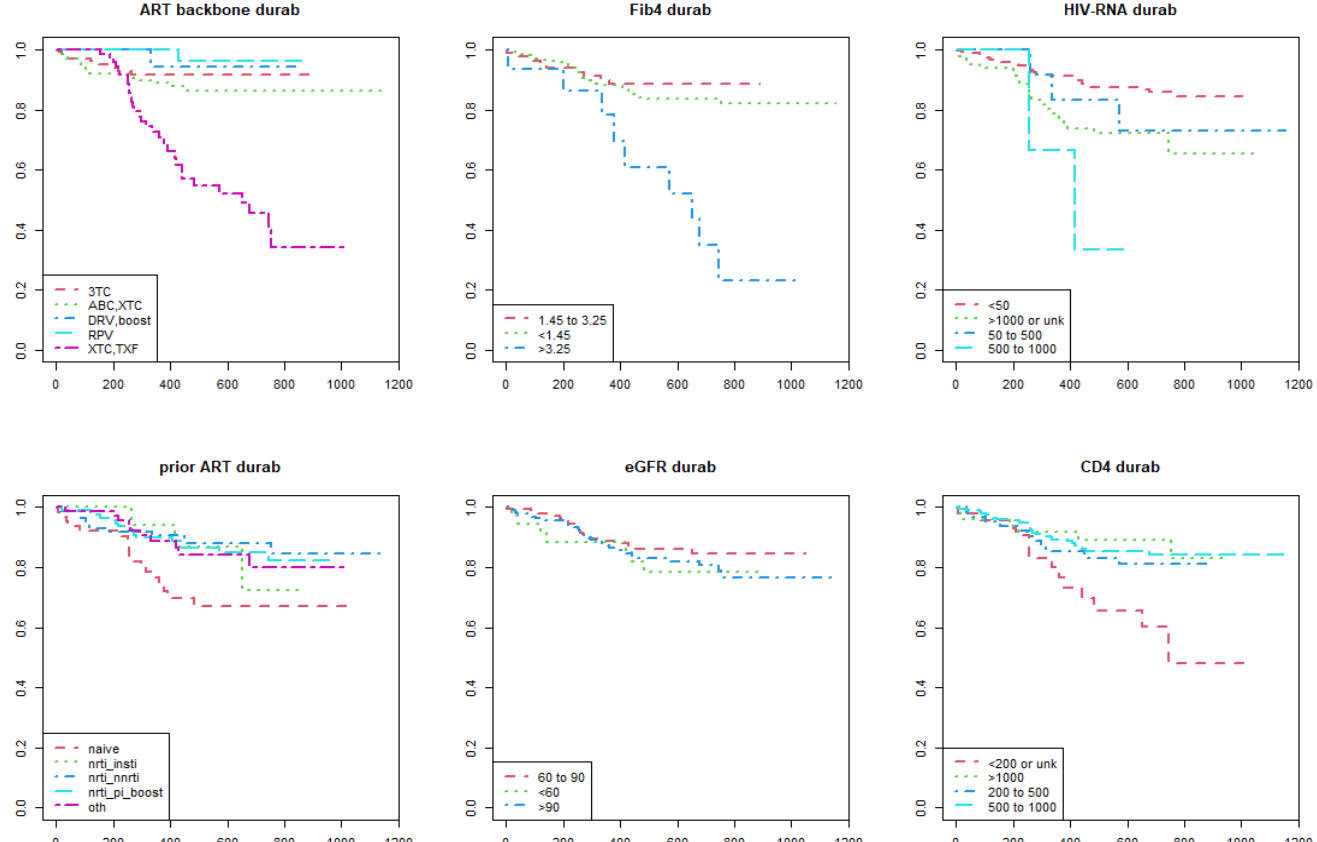
Figure 1. Kaplan–Meier survival curves show the time to a durability event (interruption) of dolutegravir-based antiretroviral therapies among people with HIV enrolled in the Italian MaSTER cohort. Plots are stratified by: ART backbone, FIB4 score, HIV RNA, previous ART, eGFR, CD4 + T-cell count. DURAB, durability; ART, antiretroviral treatment; NRTI, nucleos(t)ide reverse transcriptase inhibitors; NNRTI, non-nucleos(t)ide reverse transcriptase inhibitors; INSTI, integrase strand inhibitors; PI, protease inhibitors; RPV, rilpivirine; TXF, tenofovir alafenamide or tenofovir disoproxil fumarate; XTC, emtricitabine or lamivudine; 3TC, lamivudine; ABC, abacavir; DRV, darunavir; Boost, ritonavir-boosted regimens; OTH, other; eGFR, estimated Glomerular Filtration Rate. X -axis: time (days); Y -axis: survival rate (%).